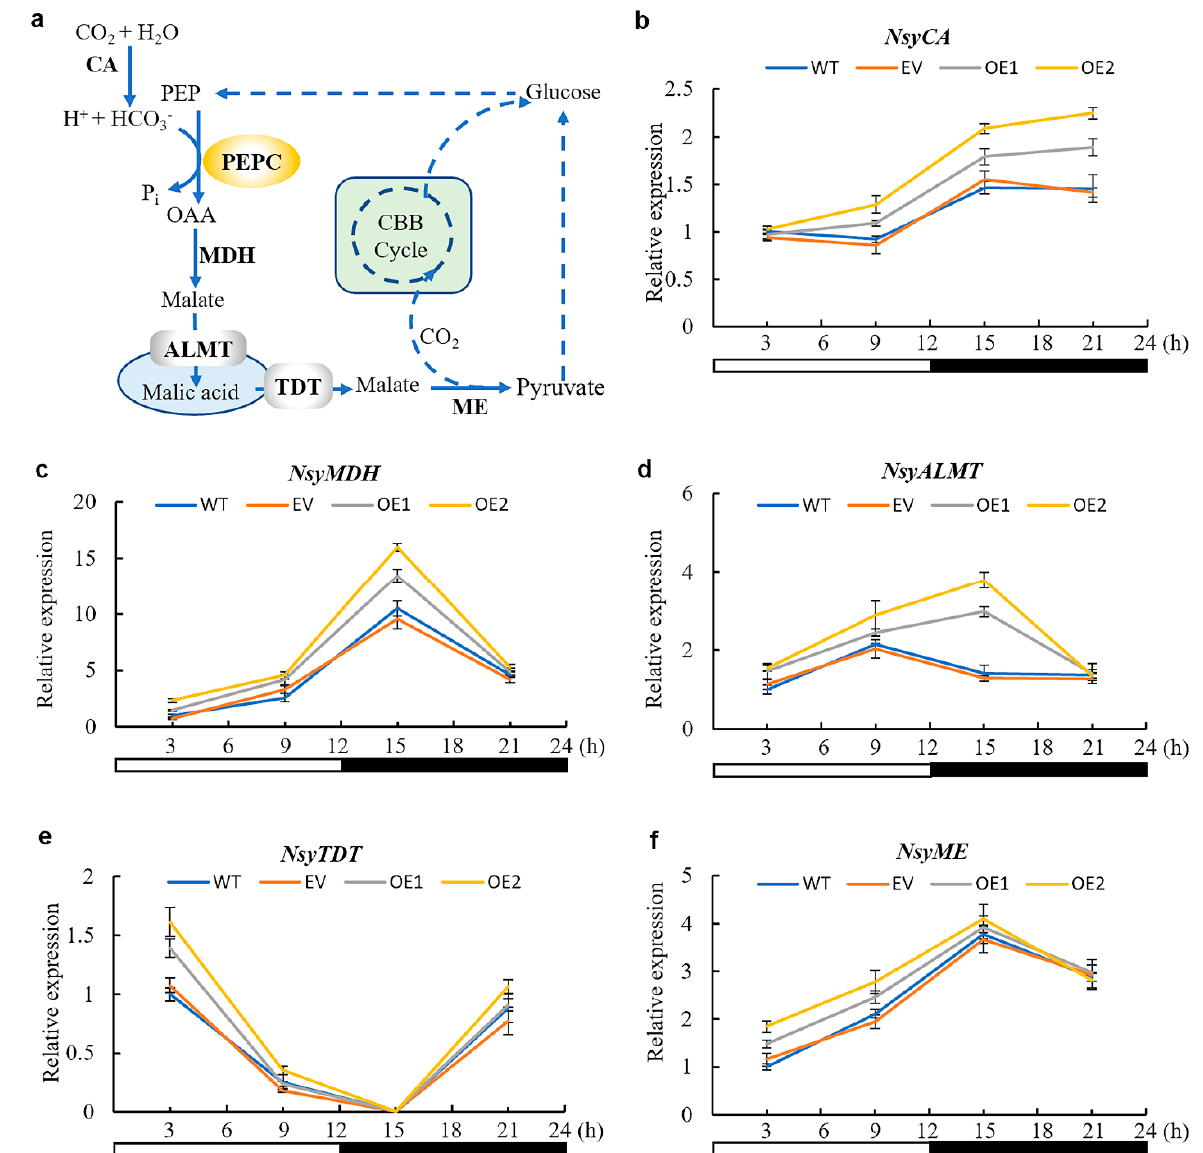
Figure 4. Relative expression level of the orthologs of CAM pathway genes in AaPEPC1 -overexpressing tobacco plants. ( a ) Diagram of the CAM pathway in malic enzyme (ME) subtype [24]. CA: carbonic anhydrase; PEPC: phospho enol pyruvate carboxylase; OAA: oxaloacetate; MDH: malate dehydrogenase; ALMT: aluminum-activated malate transporter; TDT: tonoplast dicarboxylate transporter; CBB: Calvin-Benson-Bassham. ( b – f) Relative expression level of Nicotiana sylvestris CA ( NsyCA , XM_009805732.1), NsyMDH (XM_009784202.1), NsyALMT (XM_009797046.1), NsyTDT , (XM_009797970.1) and NsyME (XM_009781546.1), respectively. The actin gene (XM_009774717.1) was used as an internal control. The values were normalized to expression in the wild-type plants (WT) at the 3 h light time-point. White and black bars indicate daytime (12 h) and nighttime (12 h), respectively. X -axis represents the time after the beginning of the light period. Values represent means ± SD (n =